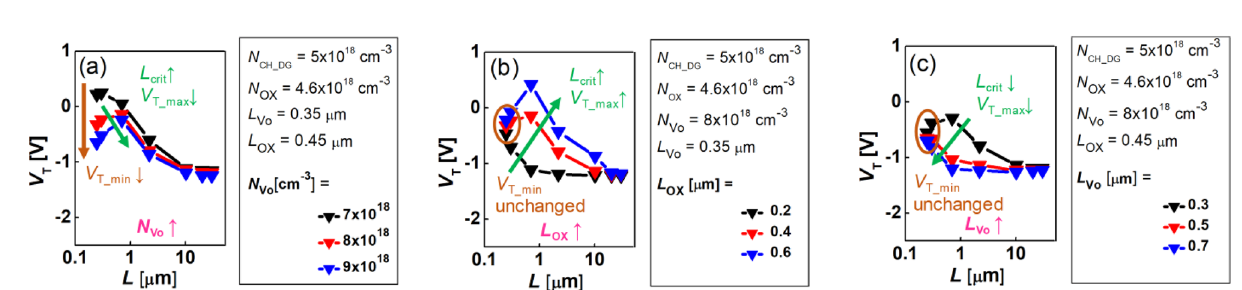
Figure 6. The TCAD simulation results for the L -dependent V T in DG FETs by splitting the ( a ) N Vo , ( b ) L OX , and ( c ) L Vo